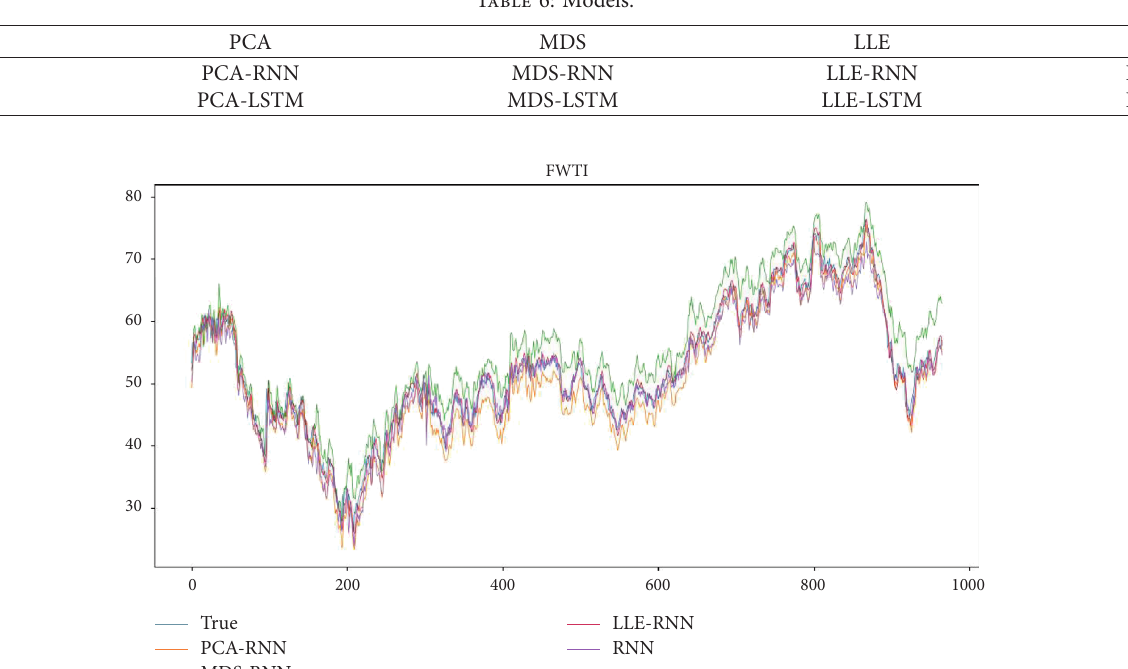
Figure 10: Prediction results of crude oil future prices by the RNN benchmark model.